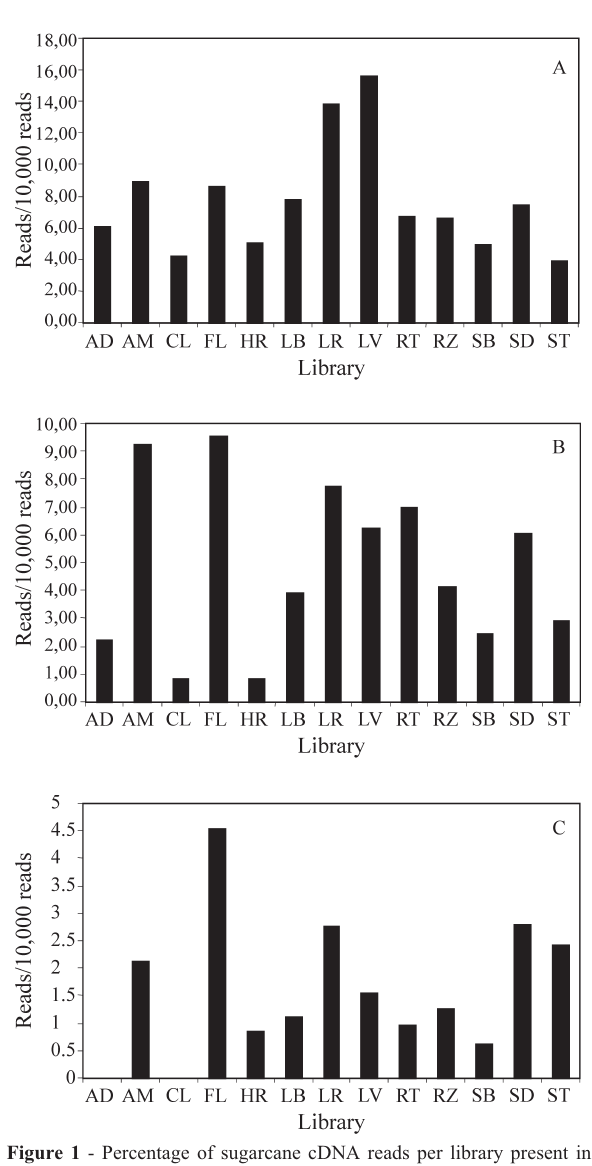
Figure 1 - Percentage of sugarcane cDNA reads per library present in three clusters of 14-3-3 protein. A = SCCCLR1022D05.g, B = SCCCRZ1001D02.g, C = SCBFLR1026E02.g. Libraries, AD = plantlets infected with Glucoacetobacter diazotroficans , AM = apical